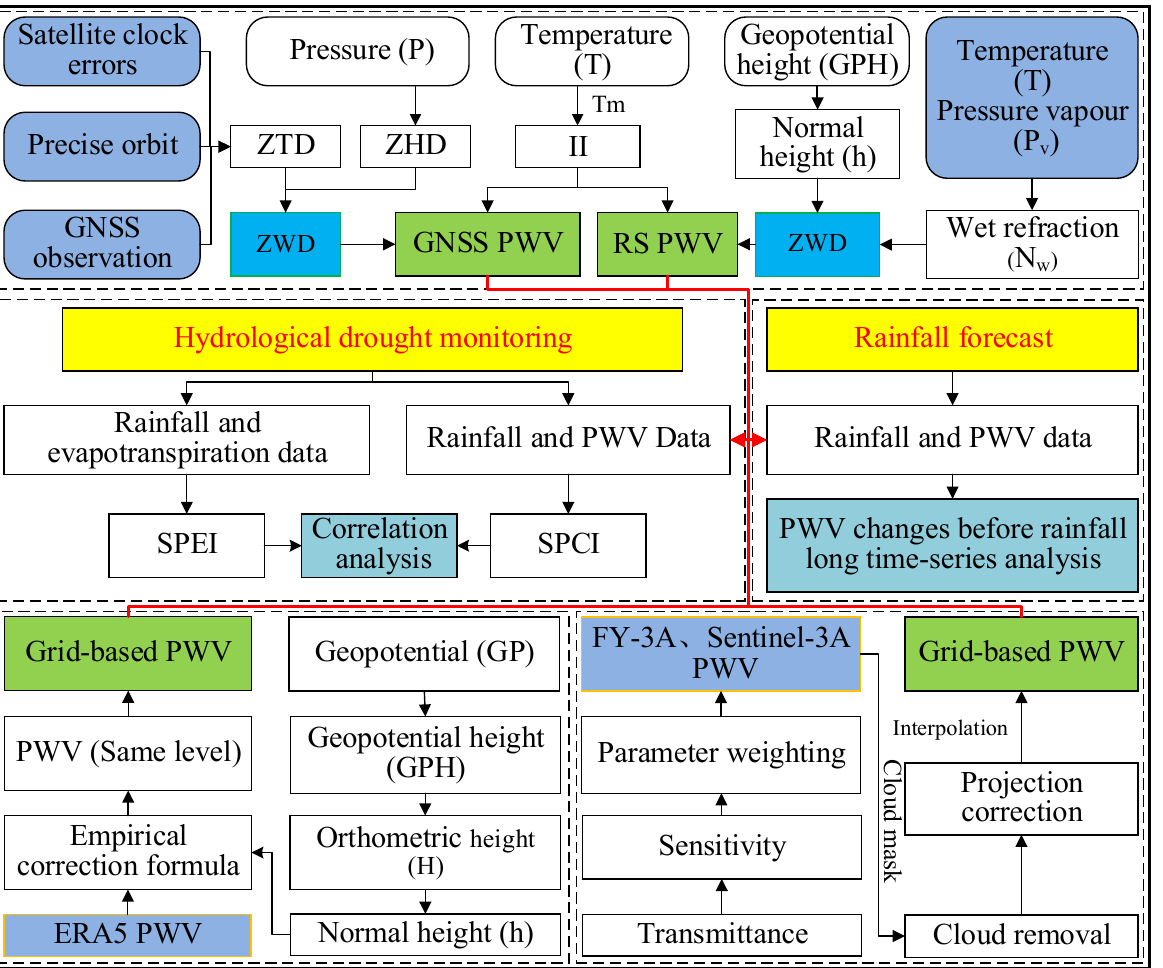
Figure 1. Flowchart of establishing CPRAP and its applications for drought and rainfall monitoring.